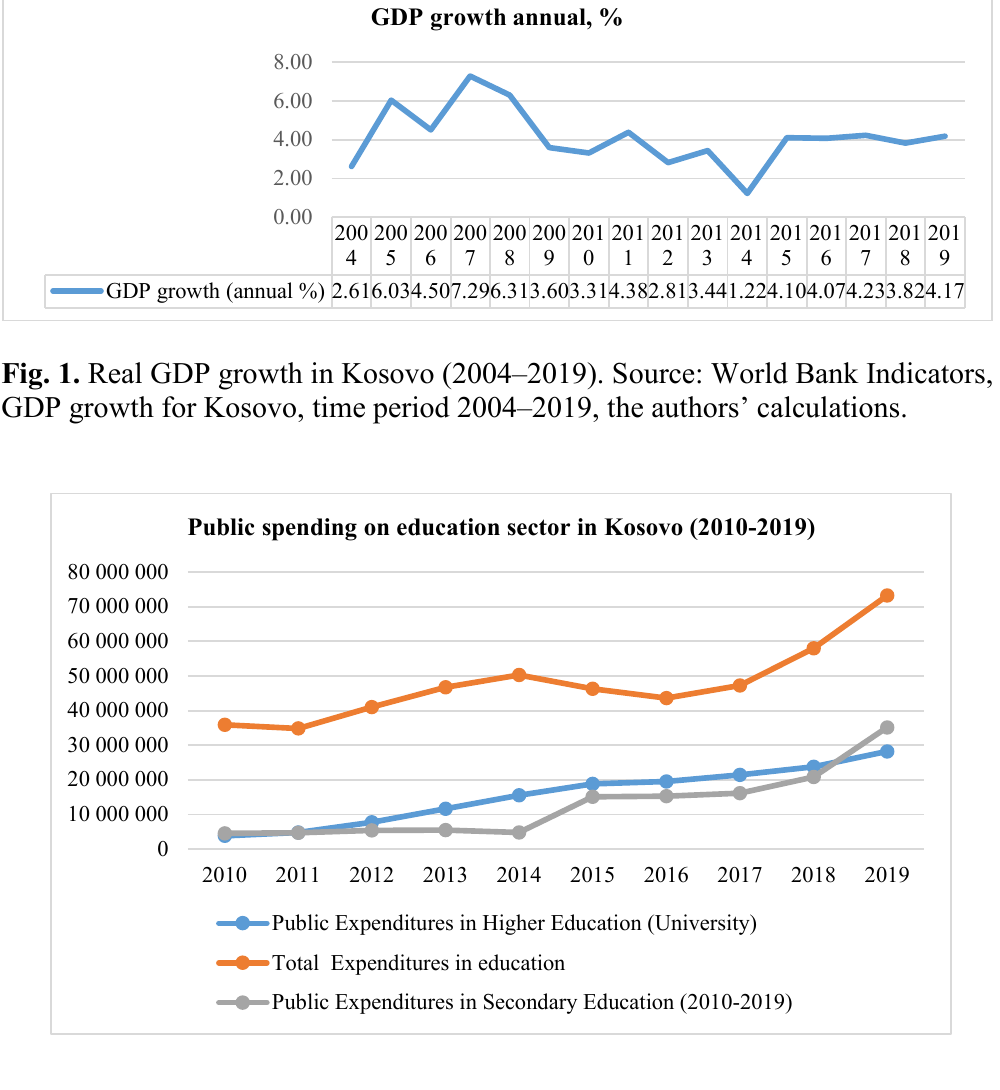
Fig. 2 . Public spending on education in Kosovo (2010–2019). Source: Ministry of Finance and Transfers, the authors’